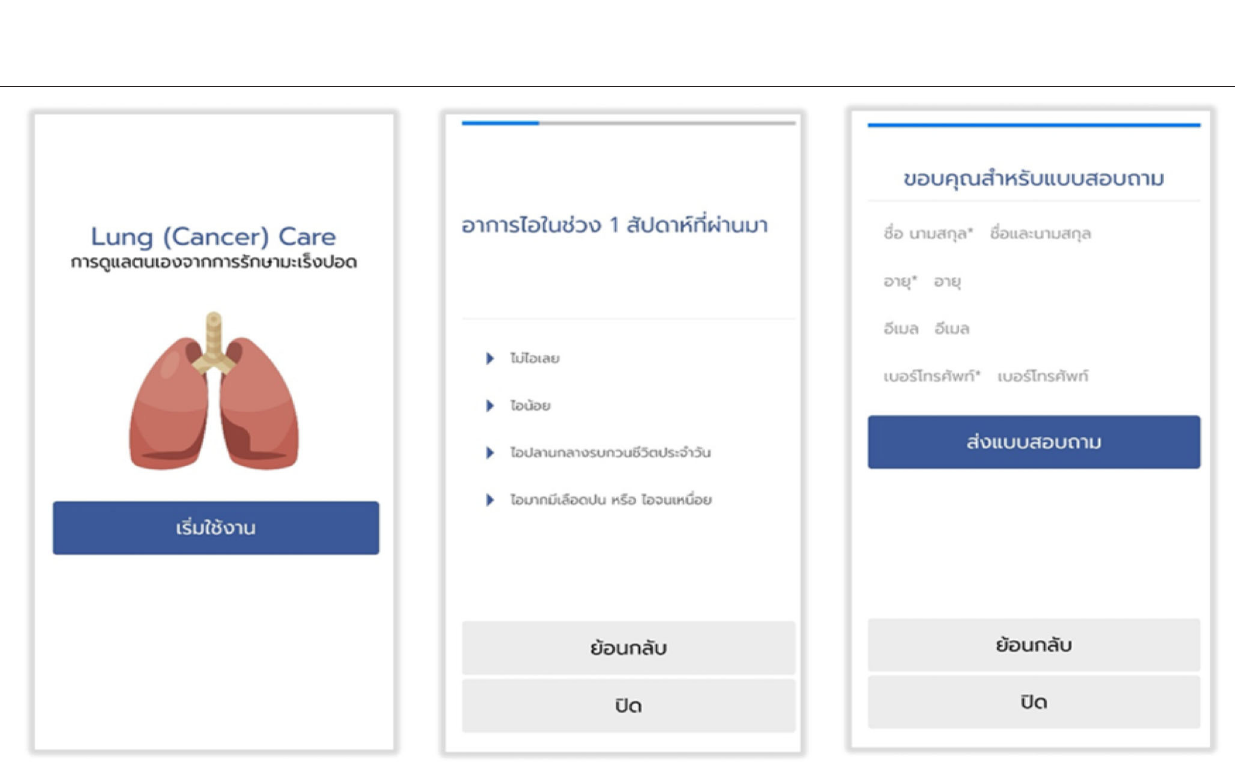
FIGURE 2 | Interface features of lung cancer care application in Thai